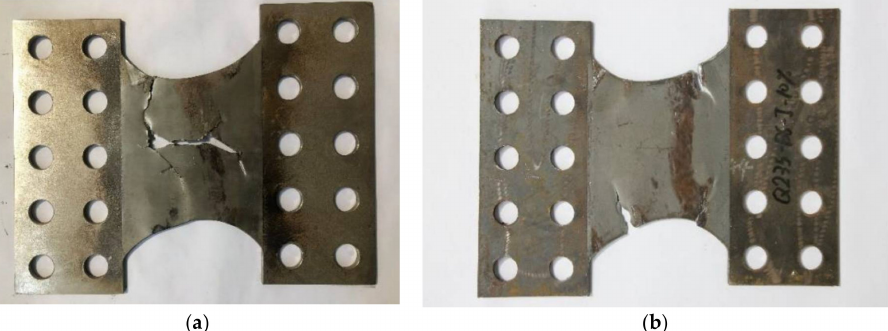
Figure 20. Macroscopic fracture behavior of ( a ) Fe-SMA-based BRS; and ( b ) Q235-based BRS under loading protocol ‘I’.